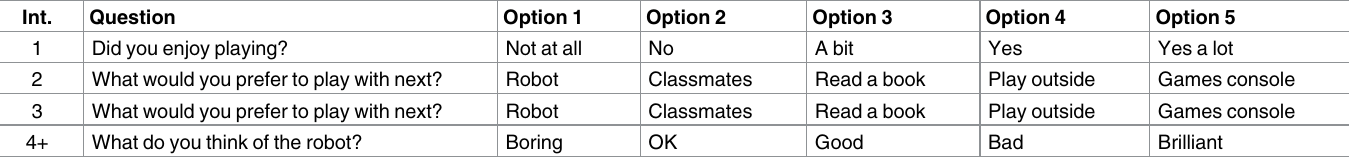
Table 2. End-of-interaction questions. Multiplechoice questionsdisplayedon the screen after each interaction, each of which had five possibleresponses.